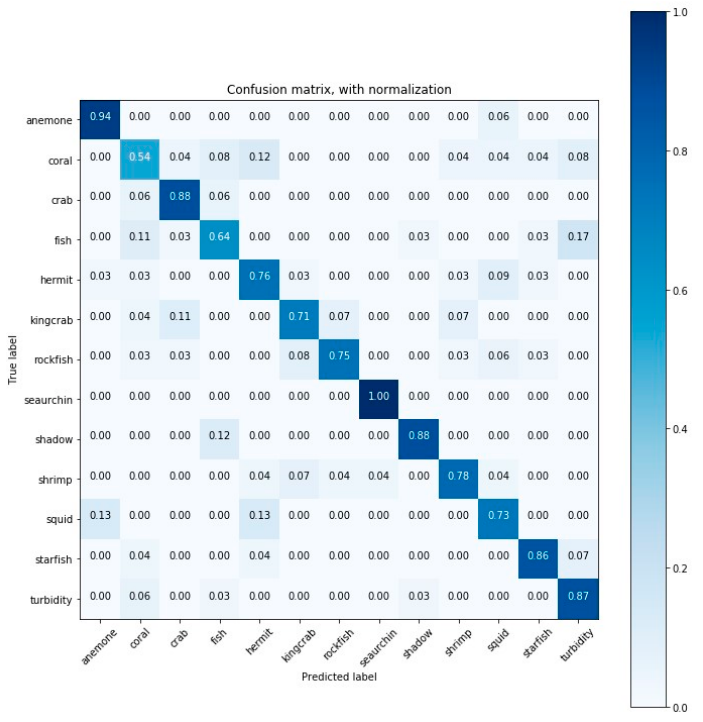
Figure A13. Confusion matrix for the classification results (accuracy) obtained by DNN-3.